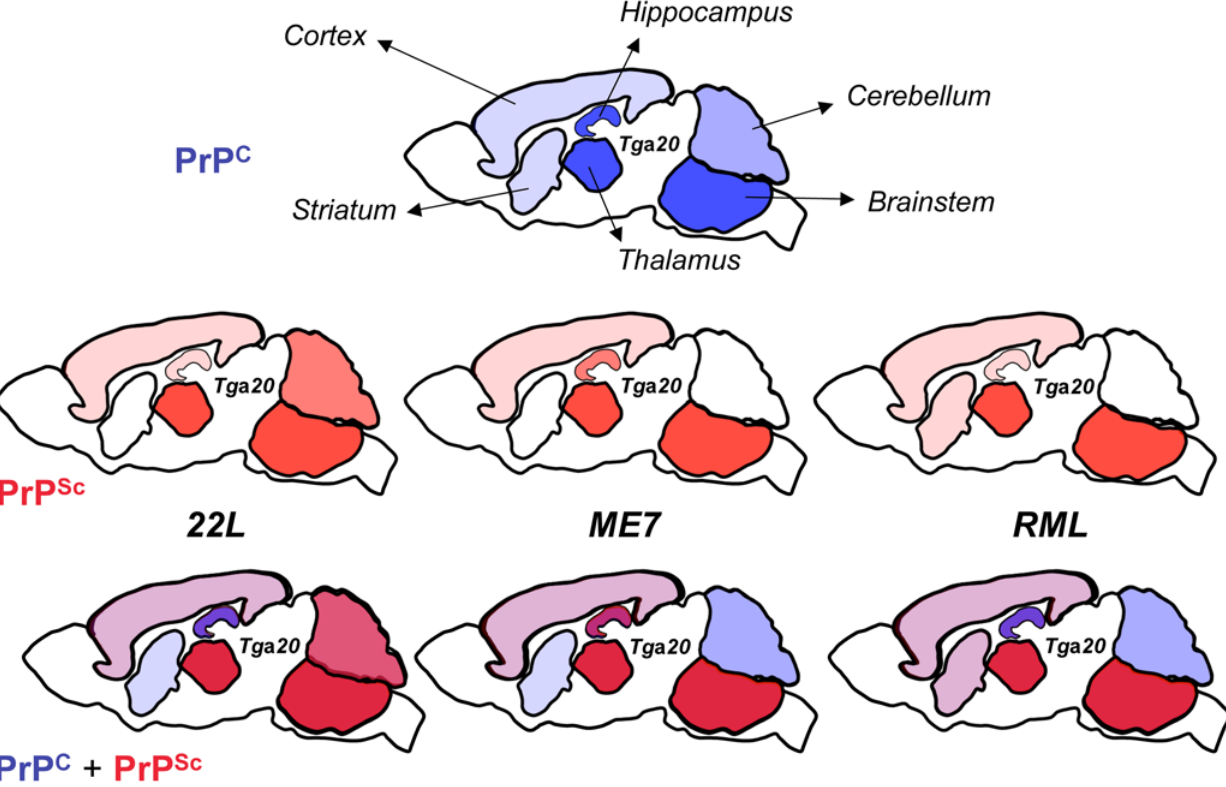
Figure 5. PrP Sc deposition does not correlate with PrP C overexpression in Tg a 20 mice and is strain specific. Schematic drawing of selected brain regions showing the intensity of PrP C overexpression (top row), PrP Sc deposition for three different scrapie strains (middle row) and the merged view (bottom row). PrP C is shown in blue, PrP Sc in red. This scheme summarizes the data described in Fig. 1, Table 1 (PrP C ), Fig. 4, Fig. S1, Tables 4 and 5 (PrP Sc